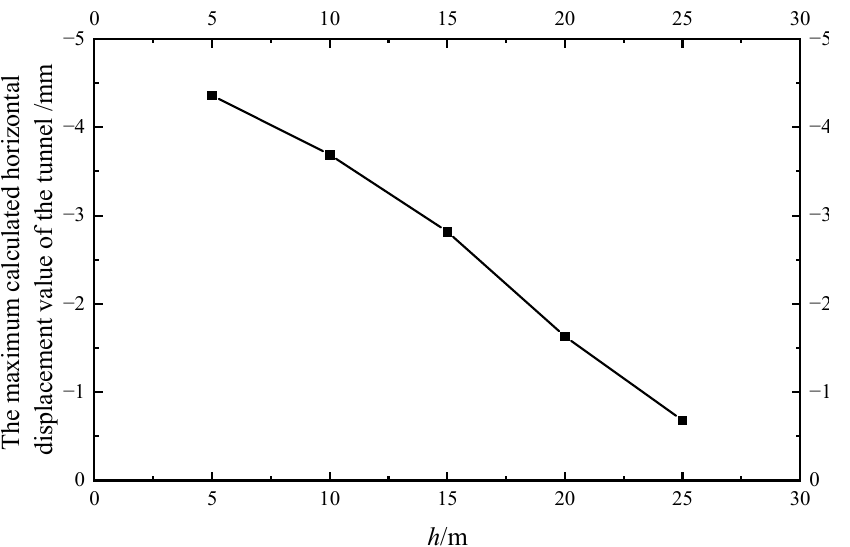
Figure 20. The calculated curve of the maximum horizontal displacement of the shield tunnel by the side of the foundation pit changing with h .